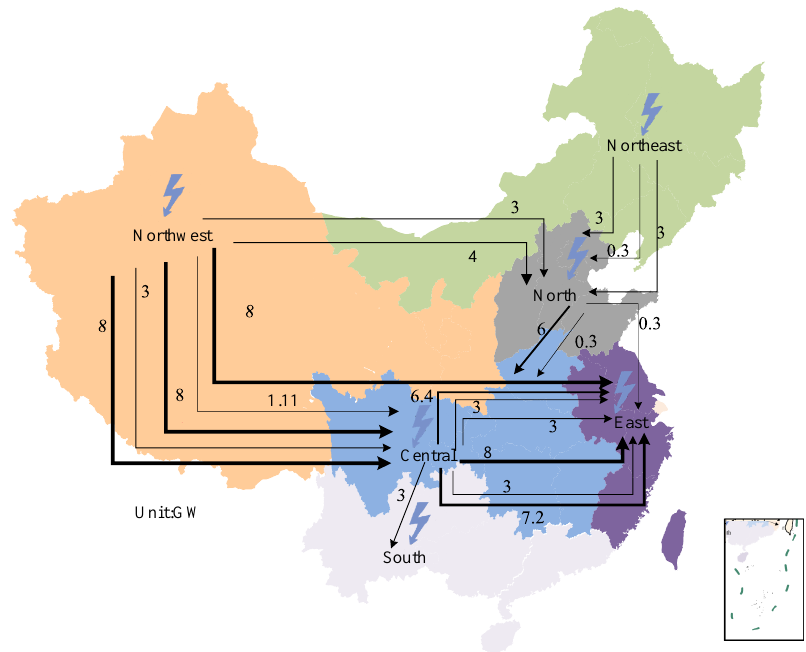
Figure 8. Interregional power transmission lines and capacity in 2016.